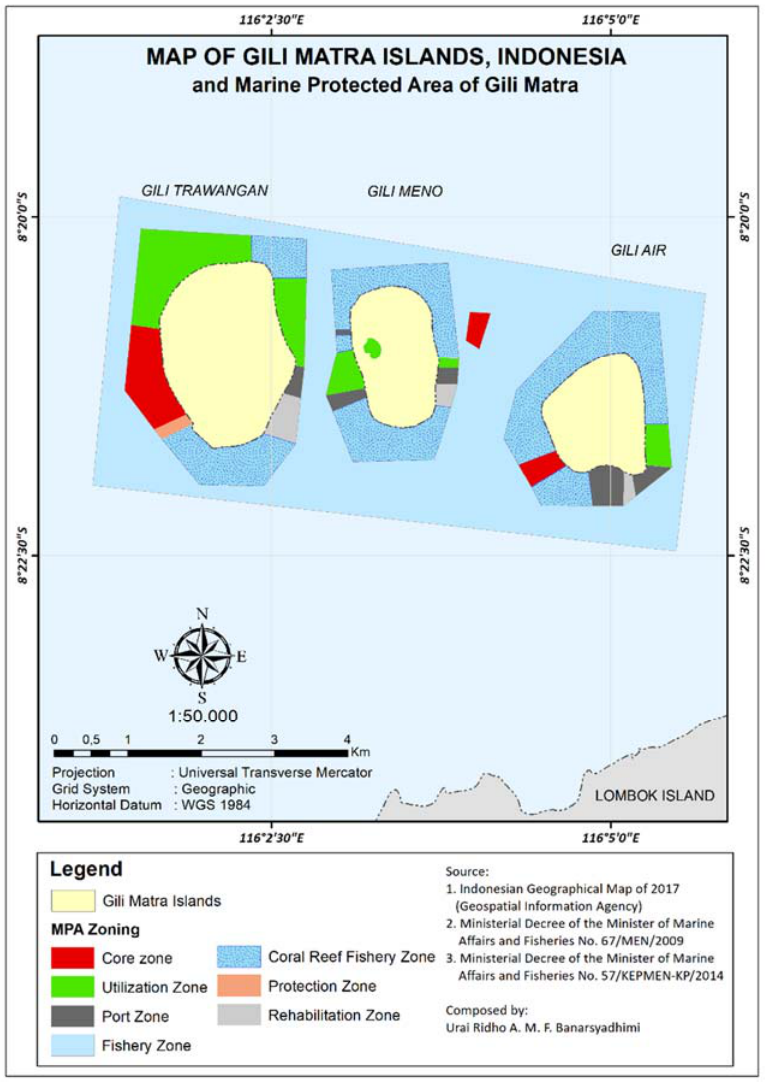
Figure 1. Adapted Map of Marine Protected Area of Gili Matra Islands [25].